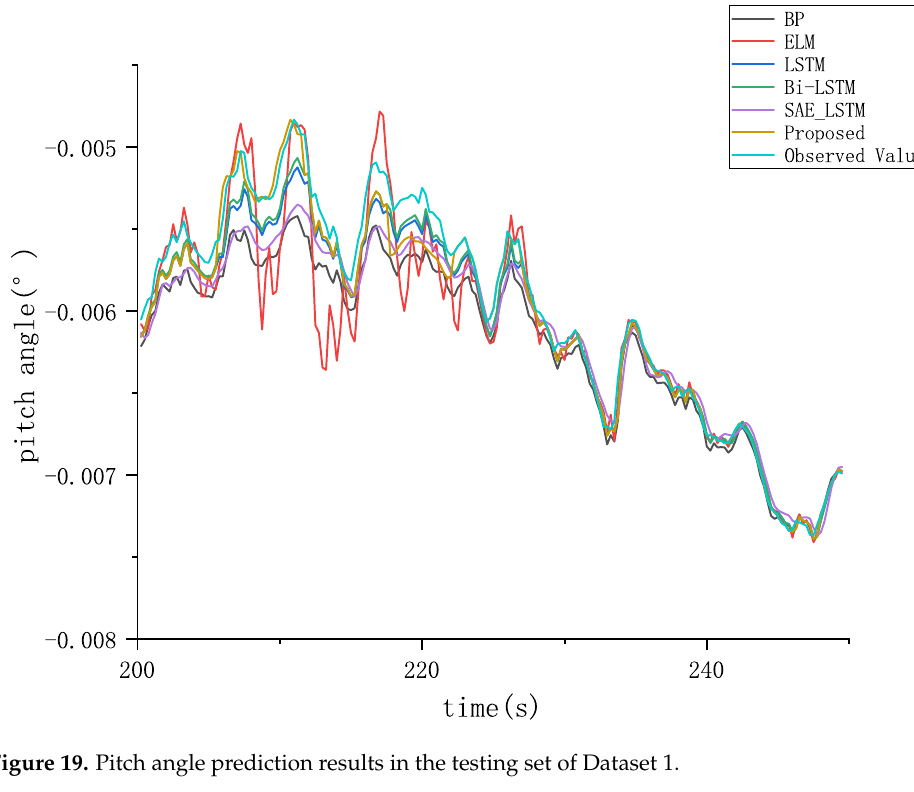
Figure 19. Pitch angle prediction results in the testing set of Dataset 1.